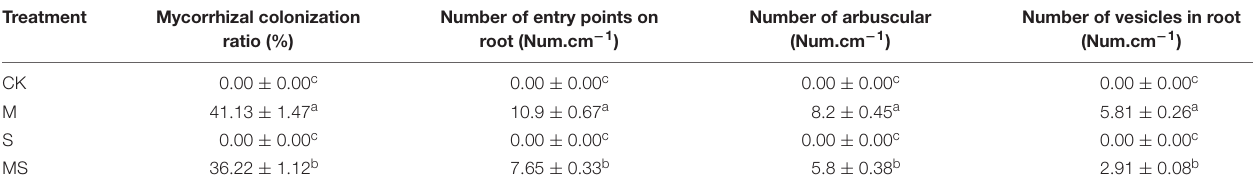
TABLE 1 | Mycorrhizal colonization and fungal structures in roots of watermelon inoculated (M, MS) or non-inoculated (CK, S) seedlings with AMF Funneliformis mosseae and subjected (S, MS) or not (CK, M) to salinity-alkalinity stress. Treatment Mycorrhizal colonization Number of entry points on ratio (%) root (Num.cm − 1 )